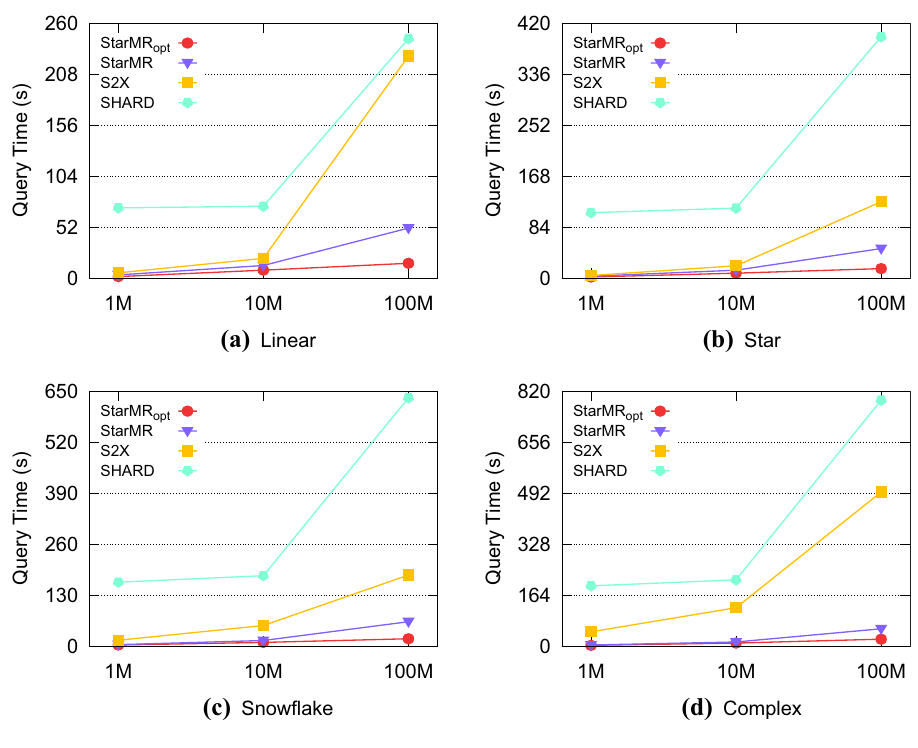
Fig. 6 Scalability on